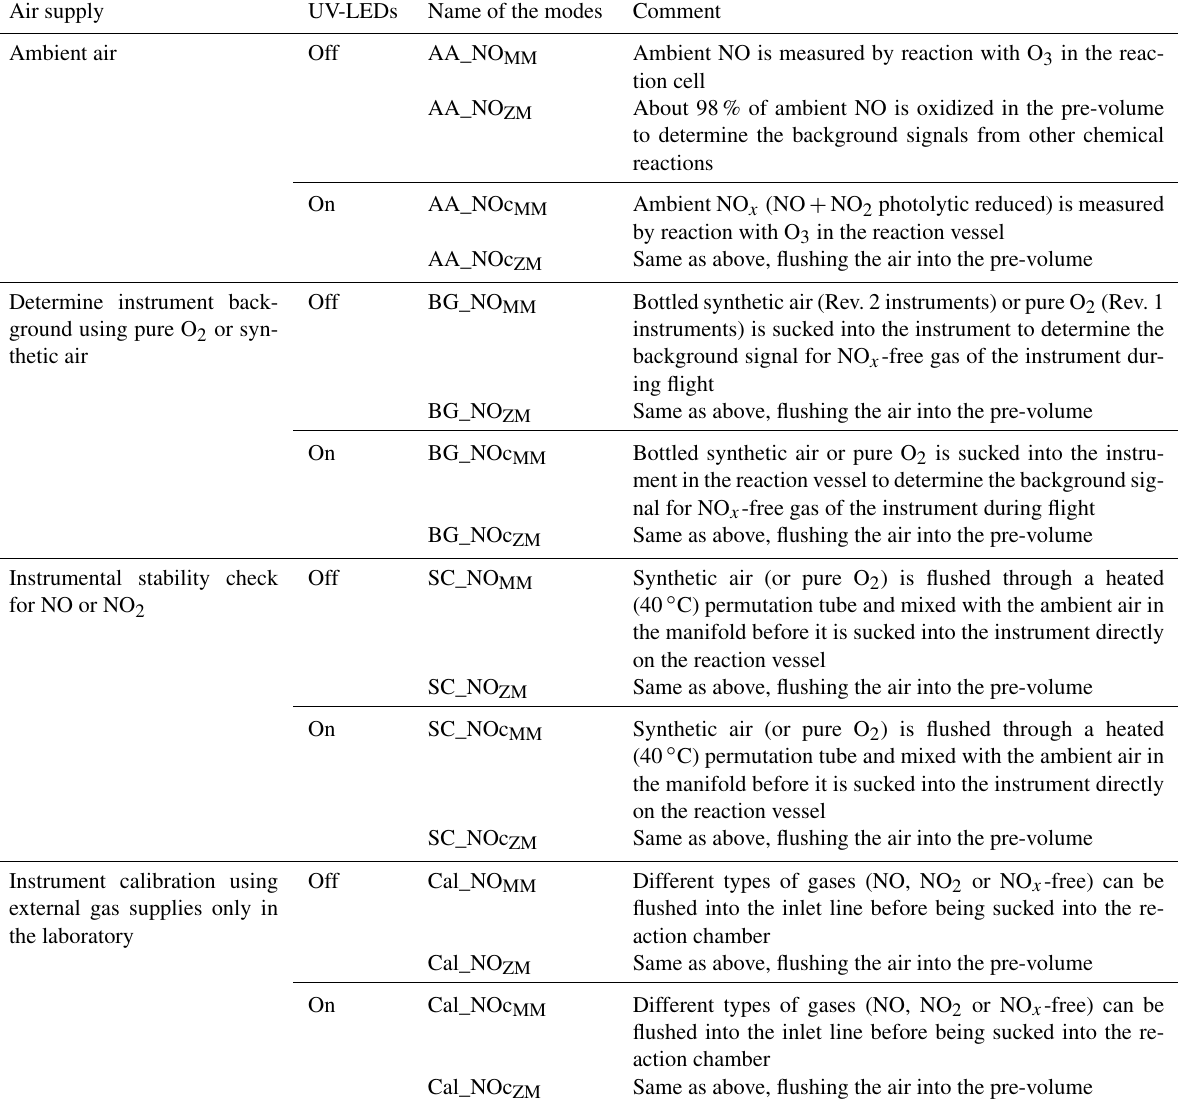
Table 3. Definition of the different modes of the instruments and their acronyms; note some of the modes are not used during flight. Air supply